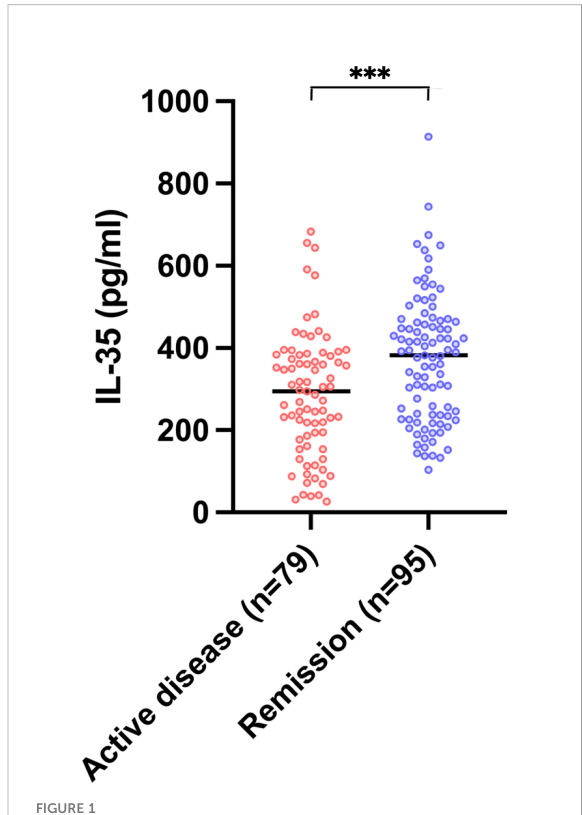
FIGURE 1 Serum IL-35 levels in IMN patients. Serum samples from174 IMN patients wereusedto measurethe concentrationof IL-35. They weredivided intotwo groups accordingtothe disease remission. Active disease (n=79) de fi ned as proteinuria >3.5g with <50% reduction frombaseline; Remission(n=95) de fi ned as the total of partial andcomplete remission. The data is expressed by median. *** represent P <0.001.IL-35,Interleukin